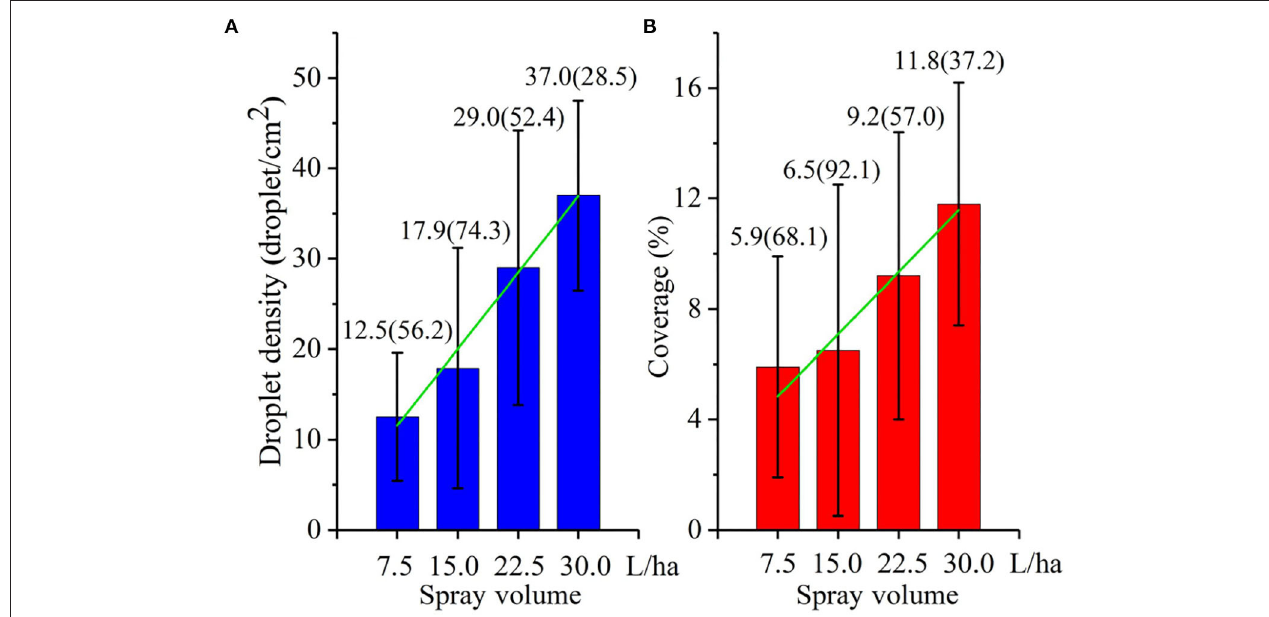
FIGURE 6 | Droplet deposition at different water application volumes for various treatments. (A) Droplet density and (B) coverage. The numbers in the figure represent the mean value (CV). The green line is a fitted curve for the droplet density/coverage and water application volume.